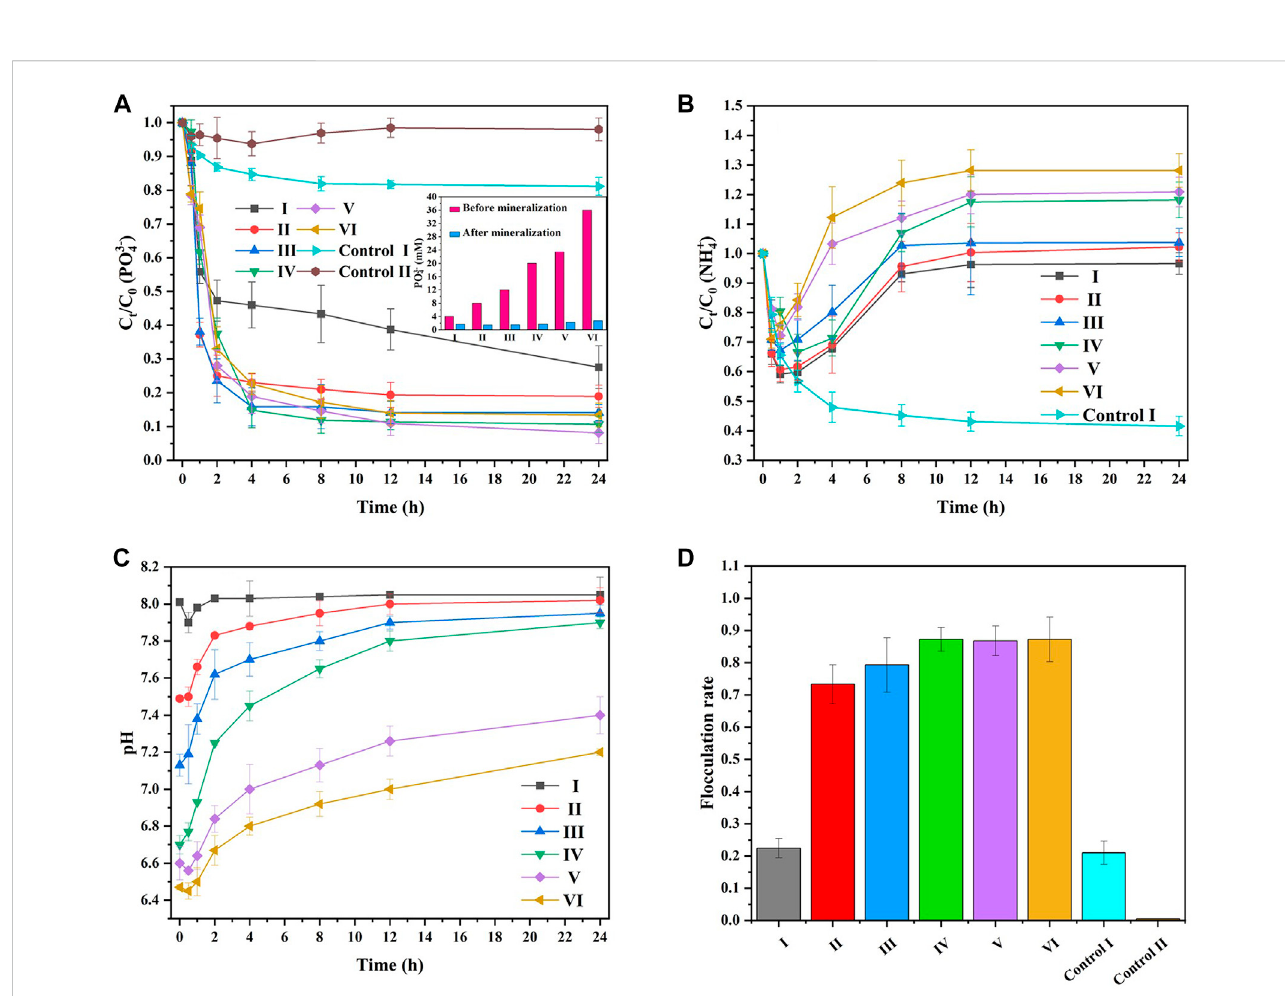
FIGURE 6 Theeliminationof (A) PO 3 − 4 (insetrepresentstheconcentrationofPO 3 − 4 correspondingtotheexperimentalgroup), (B) NH + 4 , (C) thechangeinpH,and (D) the change in fl occulation rate with